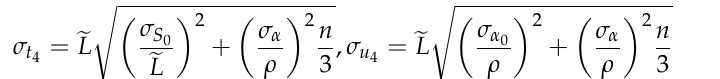
Figure 8. The chain coordinate transfer in the seafloor PNT network composed of the equilateral triangle unit network. The unit network with the yellowish point is the initial network. The white double line represents the starting edge. The golden point is the weakest point.